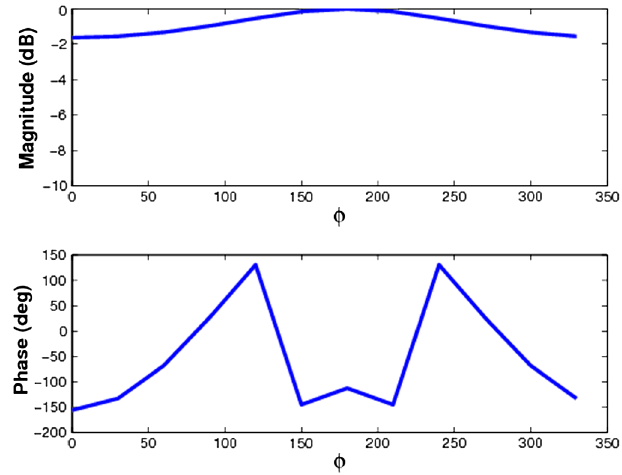
FIG. 2. The magnitude and phase of the magnetic currents required to cloak a PEC cylinder. The magnetic currents are determined by the scattered field at the boundary of the PEC